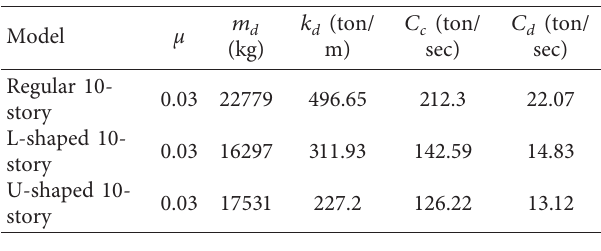
Figure 2: Comparison of response spectrum average of earthquake records with 2800 standard spectrum. Table 5: Design parameters of mass damper in regular and ir- regular 10-story models.